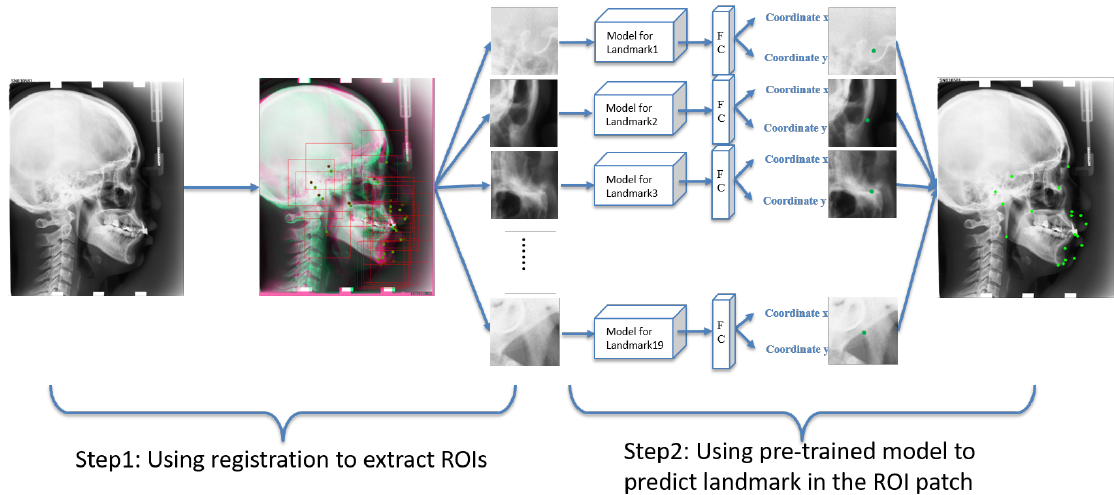
Figure 4. The overview of our two-step